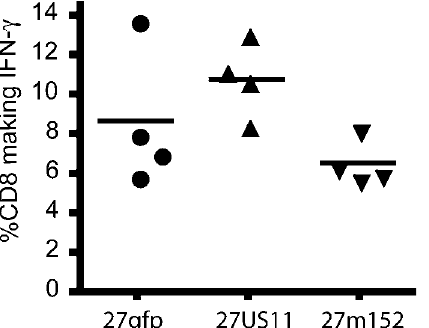
Figure 8. The Size of the CD8 T-Cell Response to rHSVs Is Not Altered by MHC Class I Inhibition Lymphocytes from the draining popliteal lymph nodes were isolated from BALB.B mice on day 6 of infection with 27gfp, 27US11, or 27m152. Lymphocytes were stimulated with HSV gB 498–505 for 5 h then stained for CD8 and intracellular IFN- c . Of the unstimulated CD8 þ cells, , 0.1% were IFN- c þ . DOI: